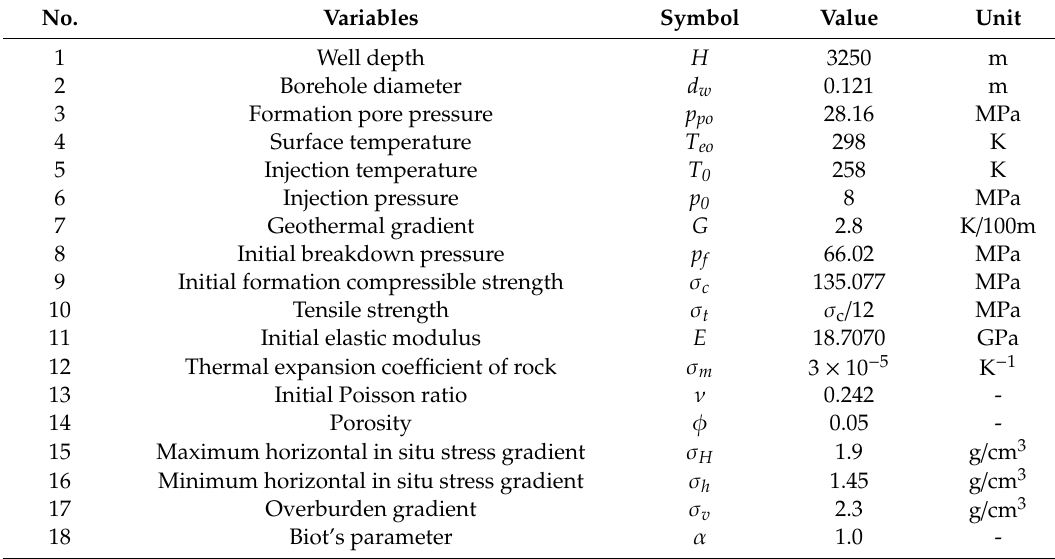
Table 1. Basic parameters for the